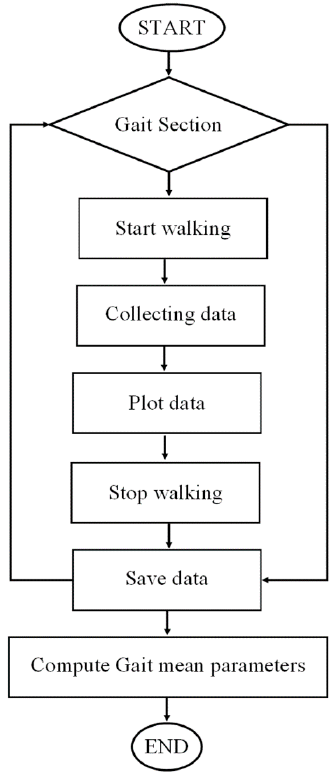
Figure 1. Gait analysis procedure flow-chart.